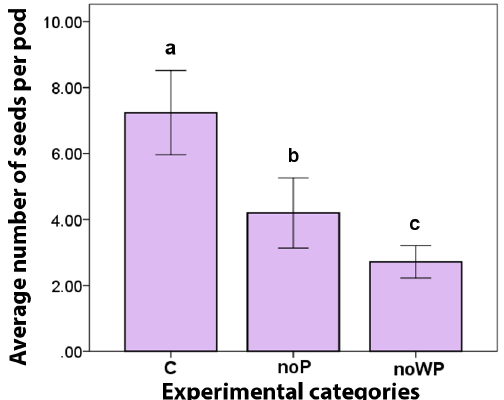
Figure 2. Average number of seed per pod, according to the experi- mental categories: control (C), exclusion of pollinators (noP), exclu- sion of wind and pollinators (noWP). Bars represent ± SE. Letters on the top of the bars indicate significant statistical difference.